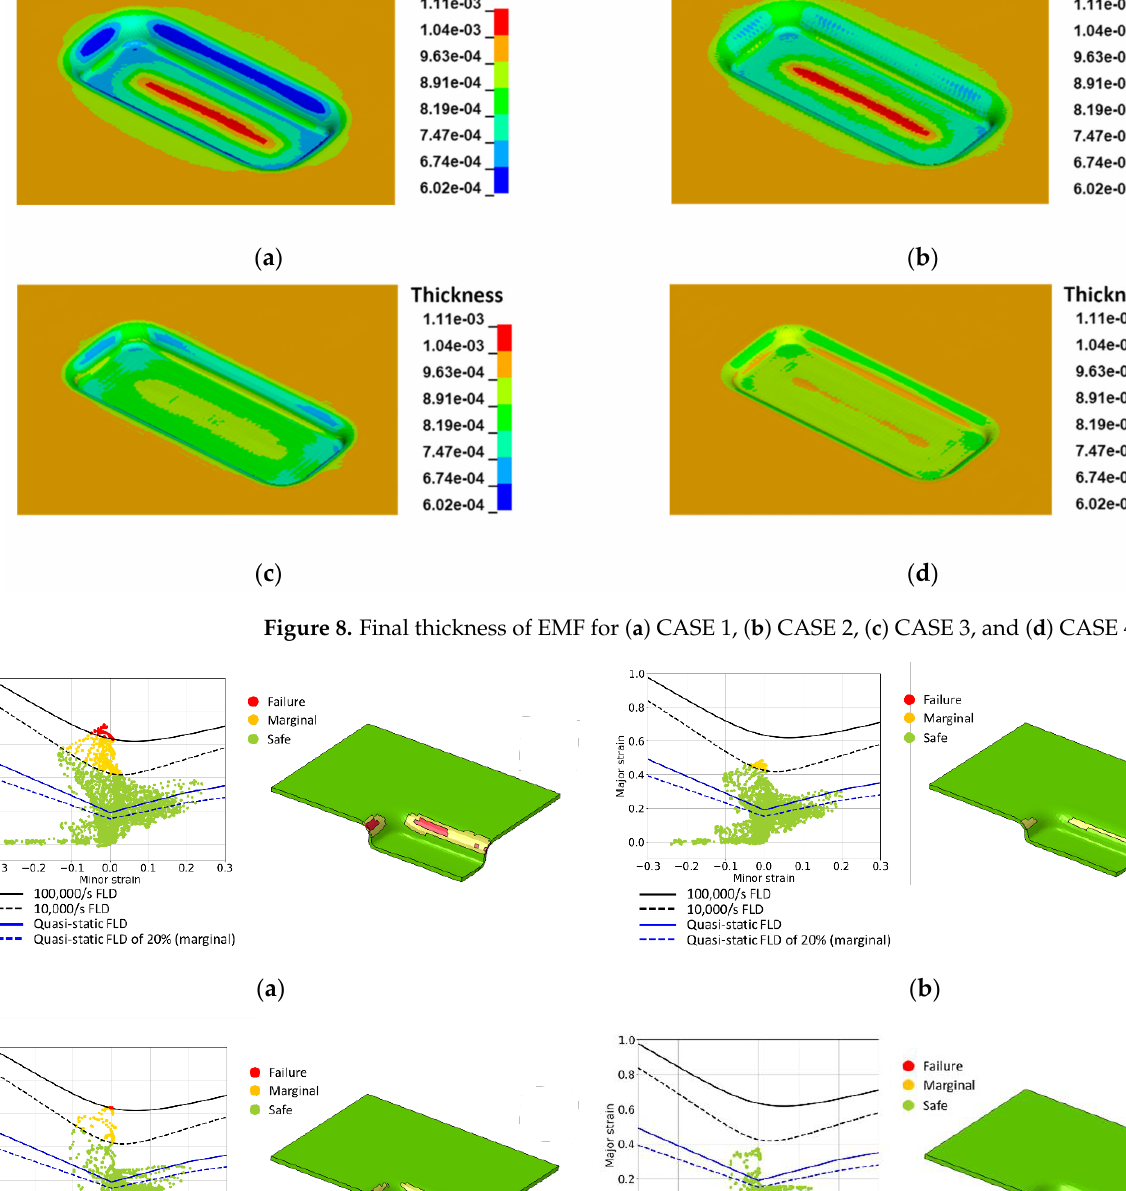
( d ) Figure 10. Distance between sheet and die (forming accuracy) for ( a ) CASE 1, ( b ) CASE 2, ( c ) CASE 3, and ( d ) CASE 4.